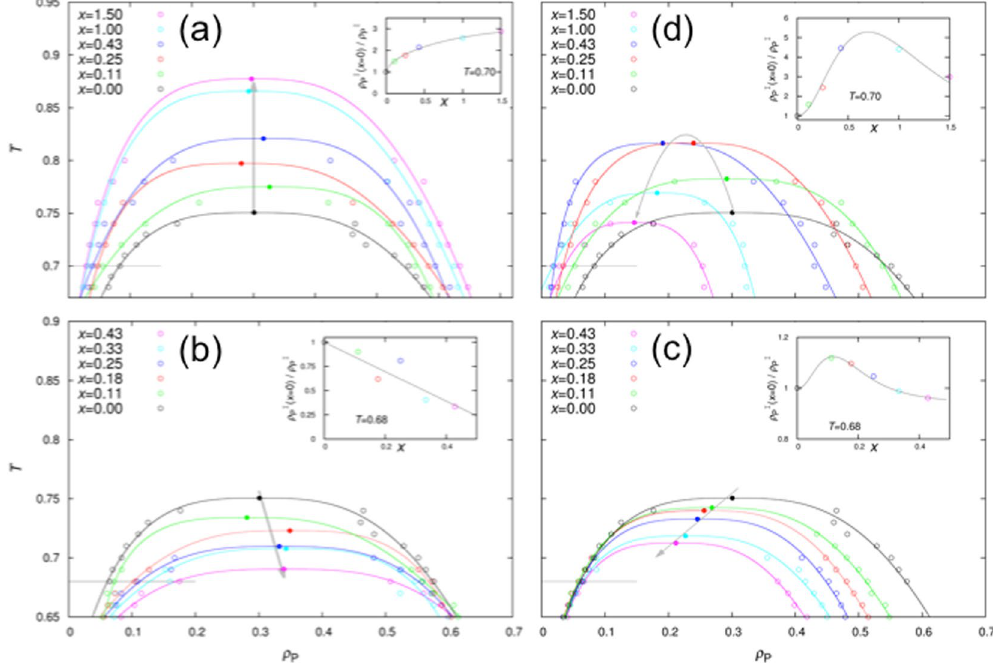
Figure 2. Phase diagrams. Results at ε PR = 0.0, 0.5, 1.0, and 1.35 are shown in ( a – d ), respectively. Open symbols are calculation results, and solid curves are fits to equation (7). The critical points from the fits are shown as filled symbols, with an arrowed gray line or parabola indicating the change with increasing X . A horizontal line through the left arm of the binodal indicates the temperature chosen for displaying results in the inset here and also in subsequent figures. Inset: ratio of threshold P concentrations between the pure P system and P-R mixture; a smooth curve is drawn to guide the